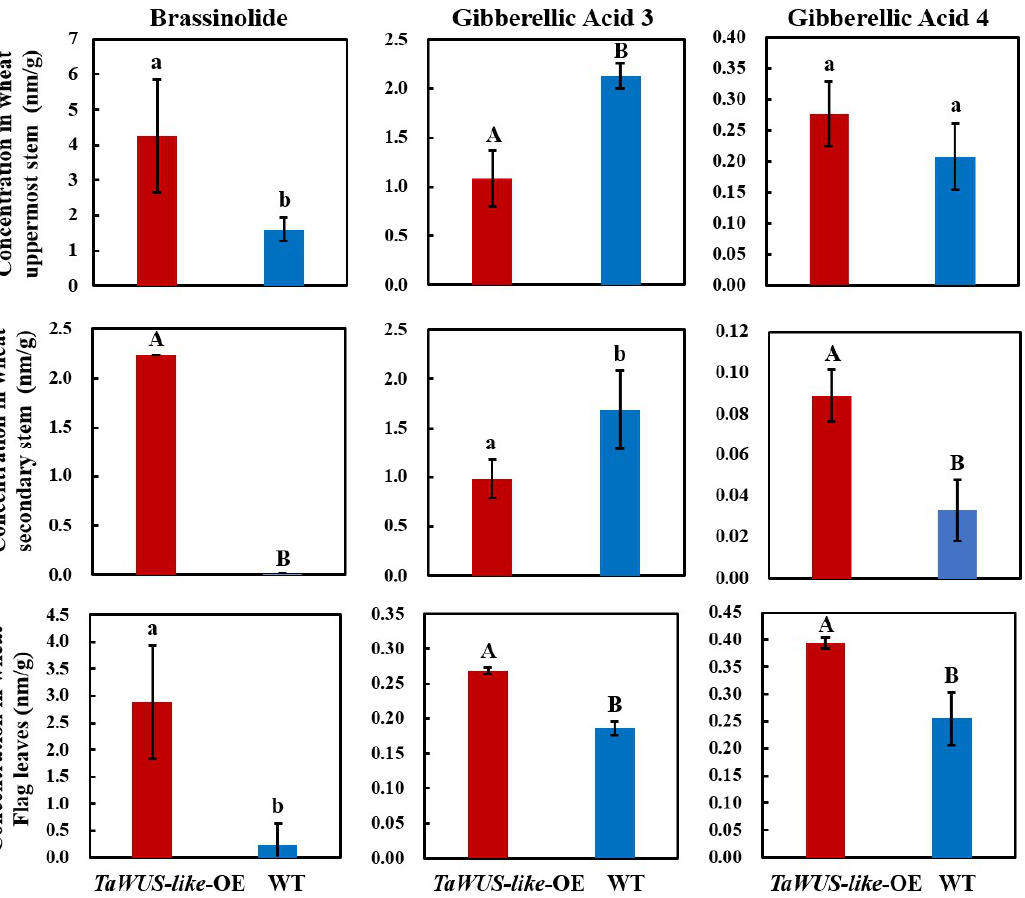
Figure 3. Hormone content determination in the internodes and flag leaf of TaWUS-like -OE lines and the WT. Uppercase and lowercase letters indicate p < 0.01 and p < 0.05, respectively.